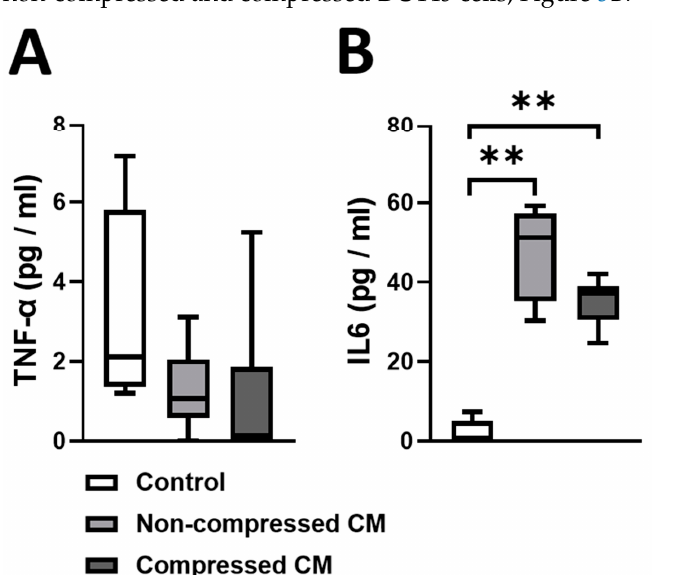
Figure 5. Protein concentrations of TNF- α and IL6 in the CM from (non)-compressed DU145 cells. DU145 cells were compressed with 2 kPa for 2 days. Subsequently, using a LEGENDplex Multi- Analyte Flow Assay Kit, we quantified ( A ) Protein concentrations of TNF- α (pg/mL) and ( B ) IL6 (pg/mL) in the CM from compressed and non-compressed DU145 cells as well as in the uncondi-